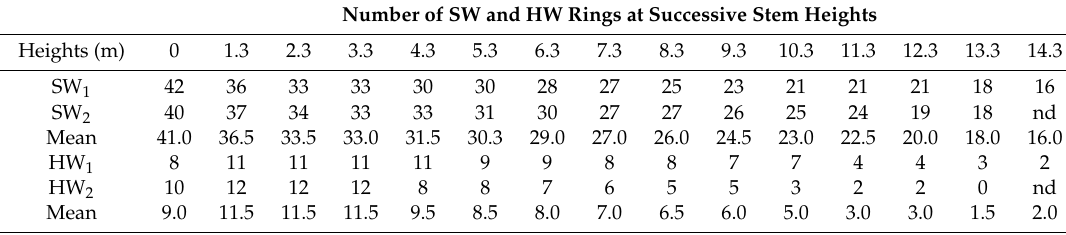
Figure 1. Details of the wood parenchyma in a Pinus sylvestris stem. ( a ) The ray parenchyma cells with elongated nuclei in sapwood (SW). ( b ) The parenchyma sheath cells of axial resin canals with rounded nuclei in SW. ( c ) Transverse section of SW and ( d ) heartwood (HW). ( e ) Radial view of the ray parenchyma cells under ultraviolet (UV) light in HW. ( f – g ) Starch grain distribution shown with I 2 KI staining in SW on radial and transverse sections, respectively. ( h ) HW stained with I 2 KI. All pictures are for breast height (BH) and for the 18th SW and the 41st HW annual ring counting from the cambium. The cambial side is the left border of the photographs. Abbreviations: r—parenchyma cells; rd—resin duct. Black arrowheads indicate the nuclei. Scale bars = 200 µm. Table 1. Spatial distribution of SW and HW rings in a Scots pine stem. Each column represents average numbers of SW and HW starting from the base of the stem and proceeding towards breast height (1.3 m above ground level) and then every 1 m to the base of the